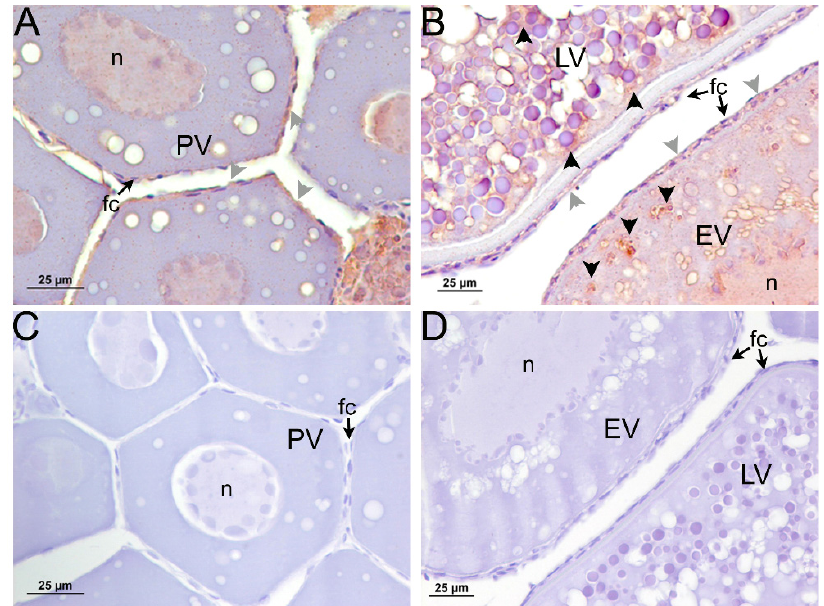
Figure 5. Immunolocalization of Amhr2 in sea bass ovaries at different developmental stages. Photomicrographs of follicles in ( A ) previtellogenesis (PV); ( B ) early vitellogenesis (EV) and ( B ) late- vitellogenesis (LV), showing an Amhr2 staining signal mainly in follicular cells (gray arrowheads) but also surrounding yolk globules inside the oocyte (black arrowheads); Control sections of ( C ) previtellogenic and ( D ) early-, late-vitellogenic follicles without primary antibody. n: nucleus; fc: follicular cell.